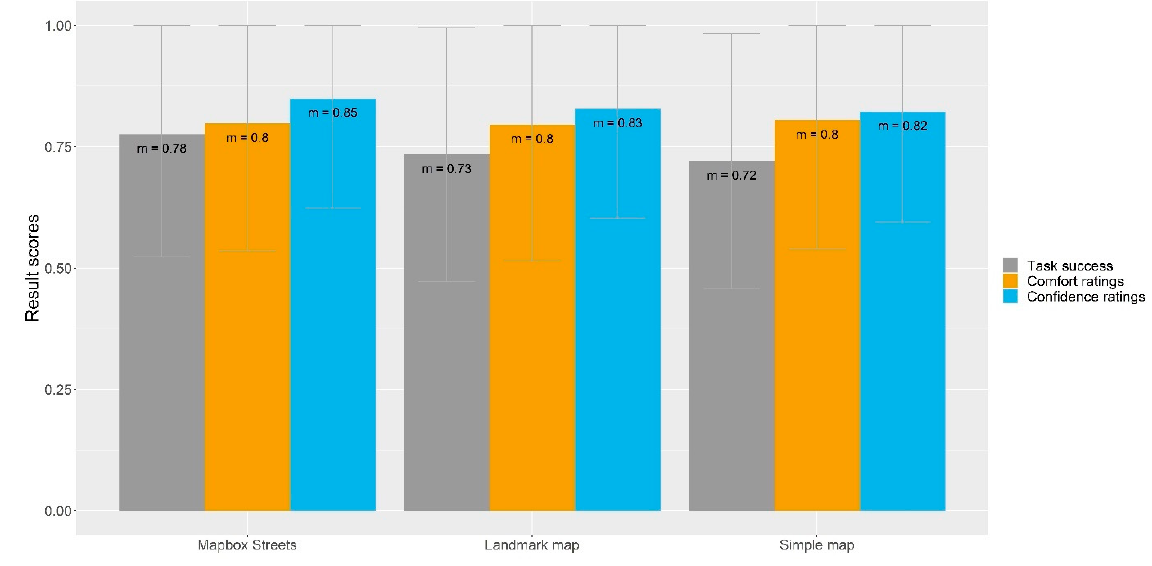
Figure 9. Task success, comfort, and confidence ratings by base map.